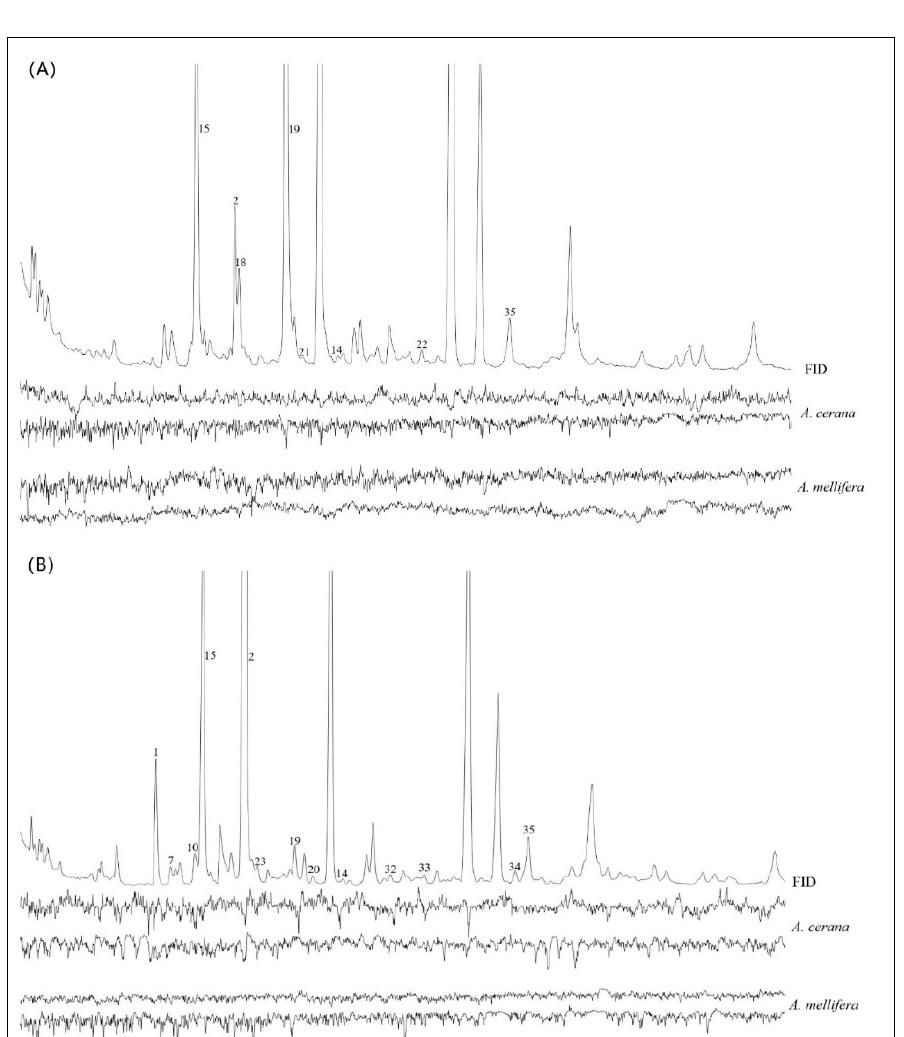
Figure 5. Examples of the antennal responses of honeybee workers (EAD) to volatiles collected from pear flowers (FID). Responses are numbered and correspond to numbers (No.) in Table